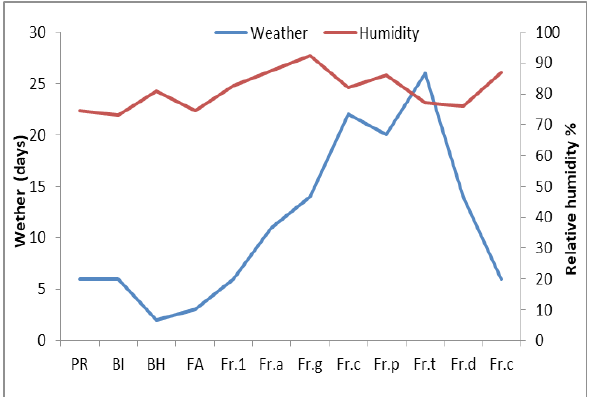
Figure 6. Fluctuation of subtle lemon (Citrus aurantifolia Swingle) from primordium to fruit harvested as a function of